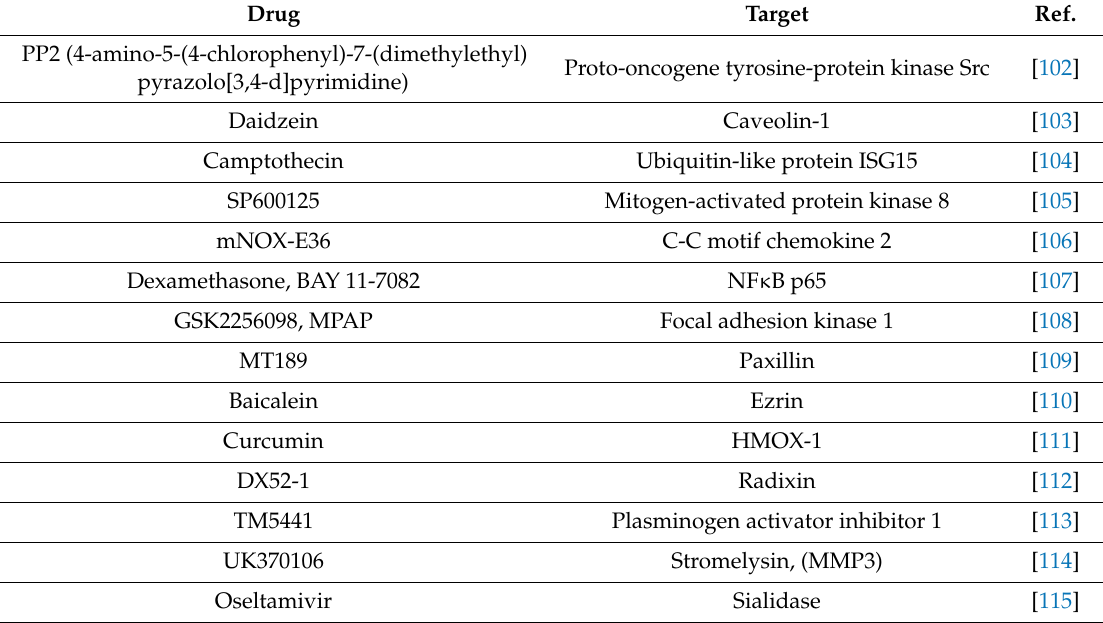
Table 4. Potential drugs targeting the proteins that were found to be influenced by µ g